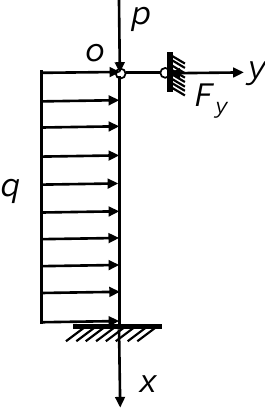
Figure 7. Either x-section force analysis plot.